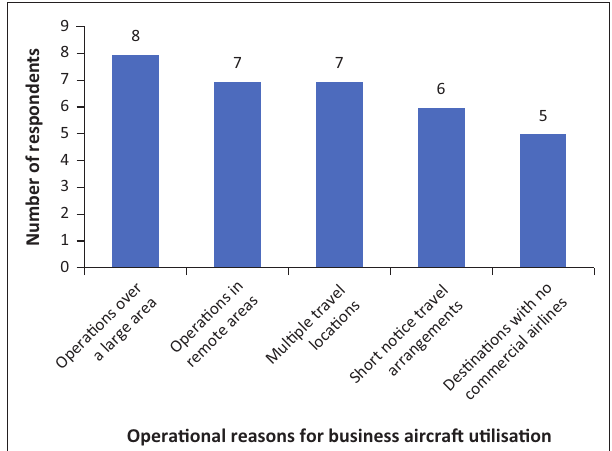
FIGURE 1: Operational reasons for utilising business aircraft ( n =